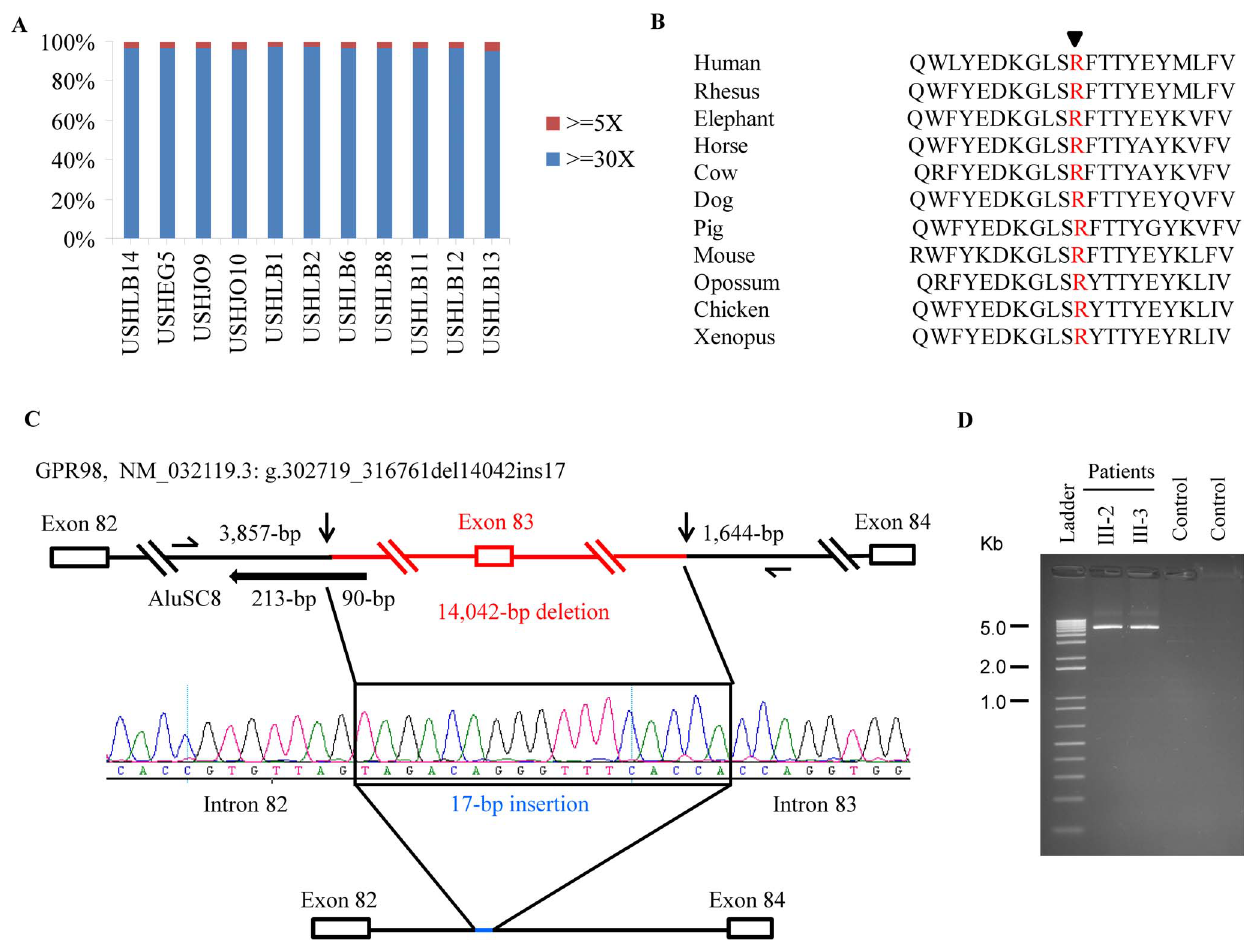
Figure 2. Exome sequencing coverage, conservation of one mutation in USH2A , and diagram of the 14,042 bp deletion in GPR98 . A. Image showing the coverage of the reads at . 30X and . 5X of the 10 Usher genes in the 11 patients studied using whole exome sequencing. B. Conservation of the Arginine (R) at amino acid 2894 in USH2A in different species is shown. C. Diagram of the rearrangement deleting exon 83 of GPR98 in family USHLB2. Arrows indicate the proximal and distal breakpoints of the 14,042 bp deletion. Horizontal arrow shows the AluSC8 repeat overlapping the proximal breakpoint. The 17 bp insertion is shown in a rectangle between the flanking sequences. Primers used for amplifying the 5.5 kb fragment are shown. D. Shows the 5.5 kb fragment amplified in the two patients III-2 and III-3 from family USHLB2. The fragment was not amplified in the two control samples due to its large size.